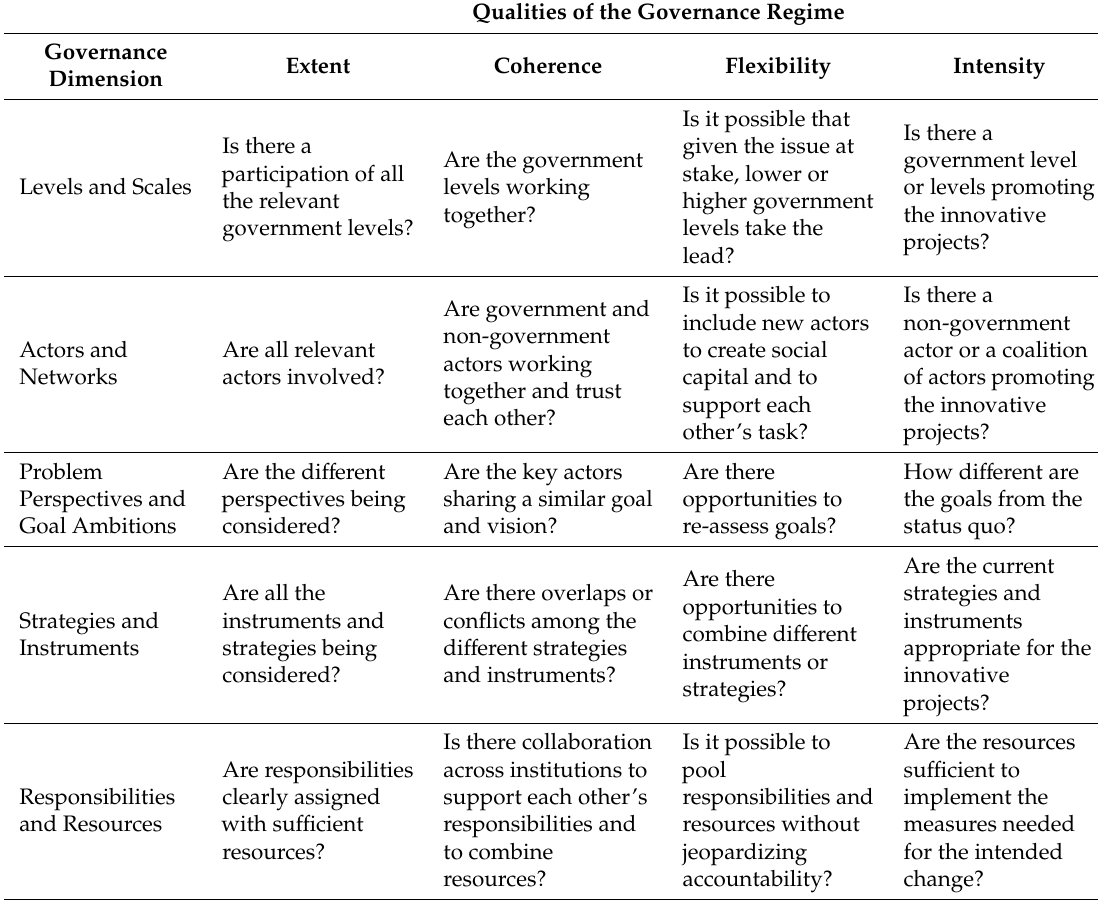
Table 1. Water governance matrix (adapt from